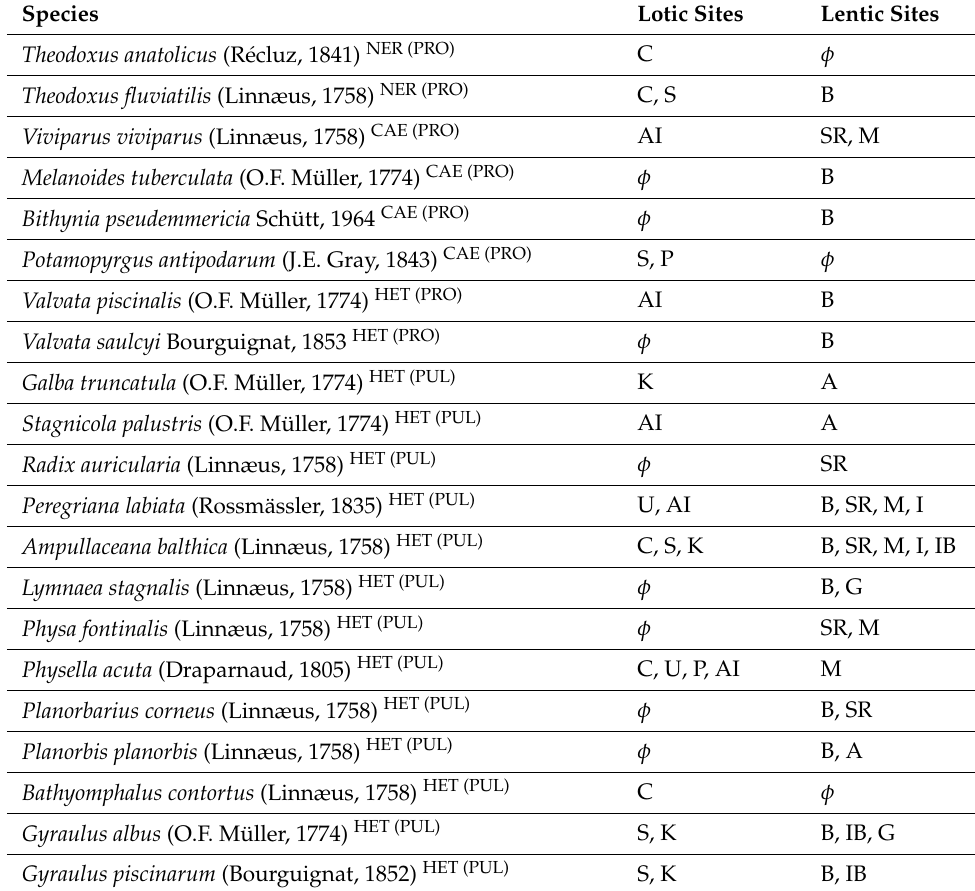
Table 3. The species list and the distribution of gastropods in sampling sites.